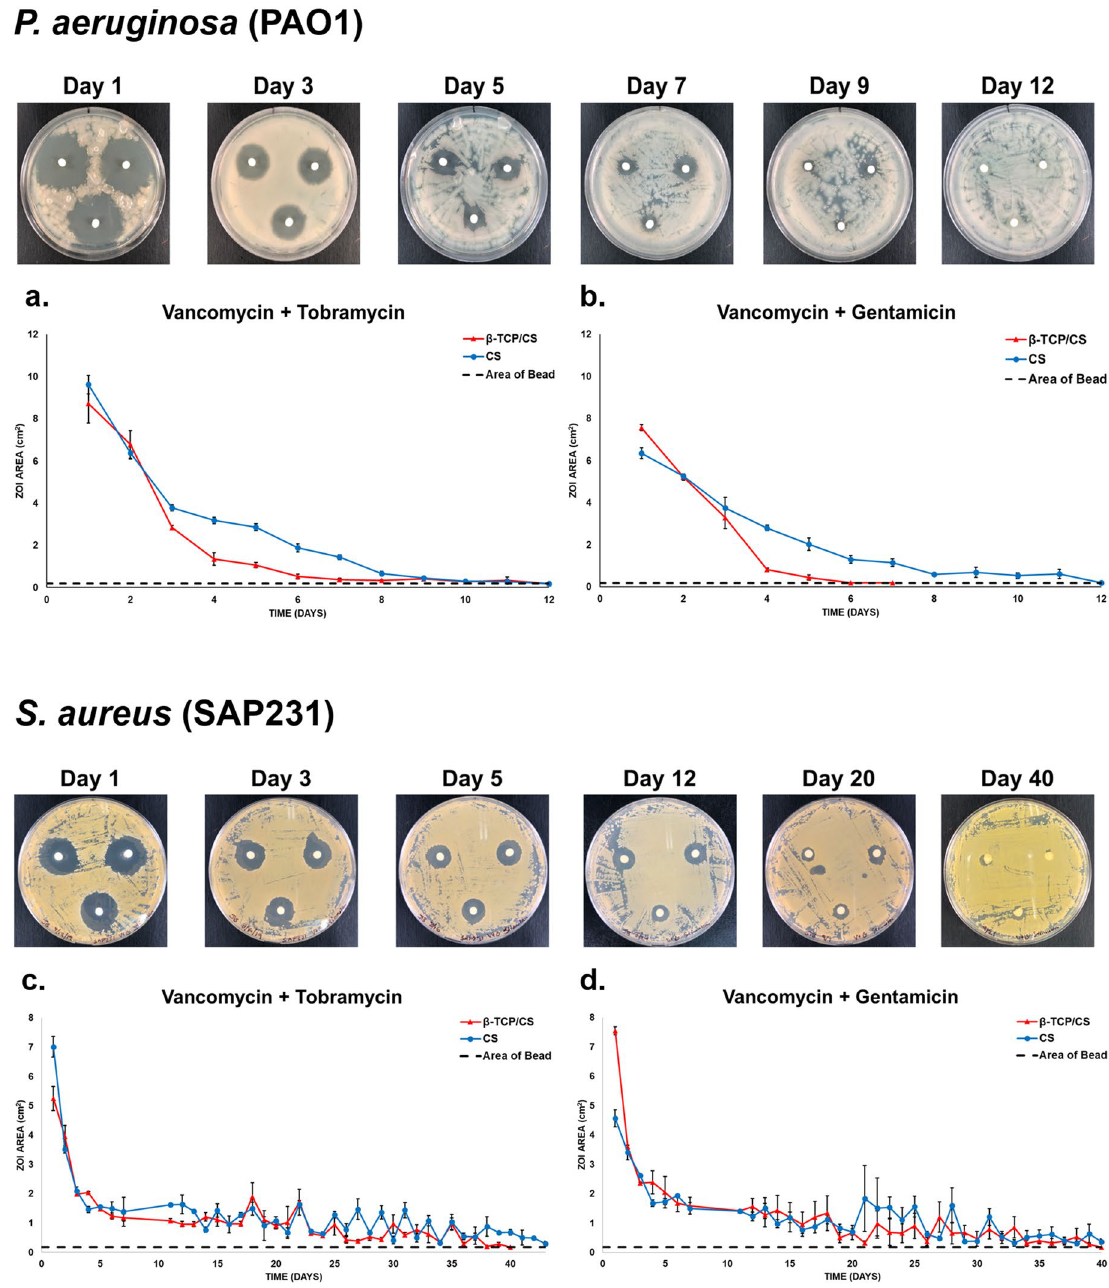
Figure 1. Repeat zones of inhibition (ZOI) of biofilm assays of PAO1 and SAP231, showing the sizes of the ZOI (in cm 2 ) from antibiotic loaded β-TCP/CS and CS beads over time. Images are representative photographs showing the ZOI from the two bacterial strains observed on agar plates at various days throughout the study. Assays were performed in triplicate, and data are expressed as the means of 3 data points ± standard error